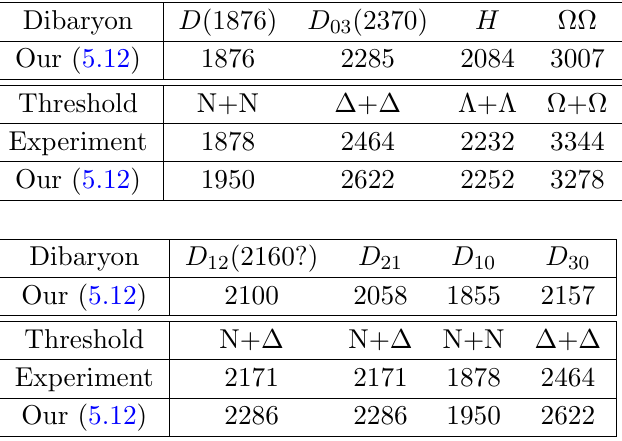
Table 5 . Comparison with the threshold for